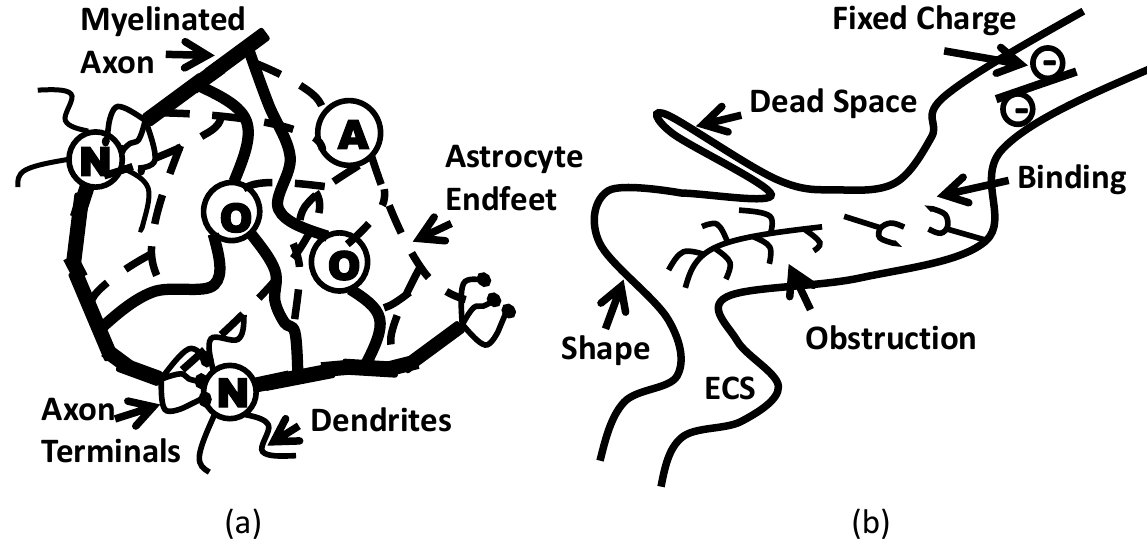
Figure 1. (a) Schematic representation of the interactions among myelinated neurons (N), astrocytes (A) and myelinating oligodendrocytes (O). Astrocytes have numerous specialized connections (Endfeet) to other astrocytes, the soma, dendrites and axons of neurons, the soma and processes of oligodendrocytes, and the brain fluid barriers. Neurons and astrocytes control the production and assembly of the myelin sheath around the axons by the oligodendrocytes. One oligodendrocyte can myelinate many axonal segments belonging to different neurons. Interactions among astrocytes and oligodendrocytes are controlled by gap junctions, while neuronal interactions happen through electrical and chemical synapses. (Adapted from [16]) (b) Schematic representation of the diffusion barriers of the ECS: geometry, dead space microdomains, obstruction by the extracellular matrix, biding sites, and fixed negative charges on the extracellular matrix (adapted from